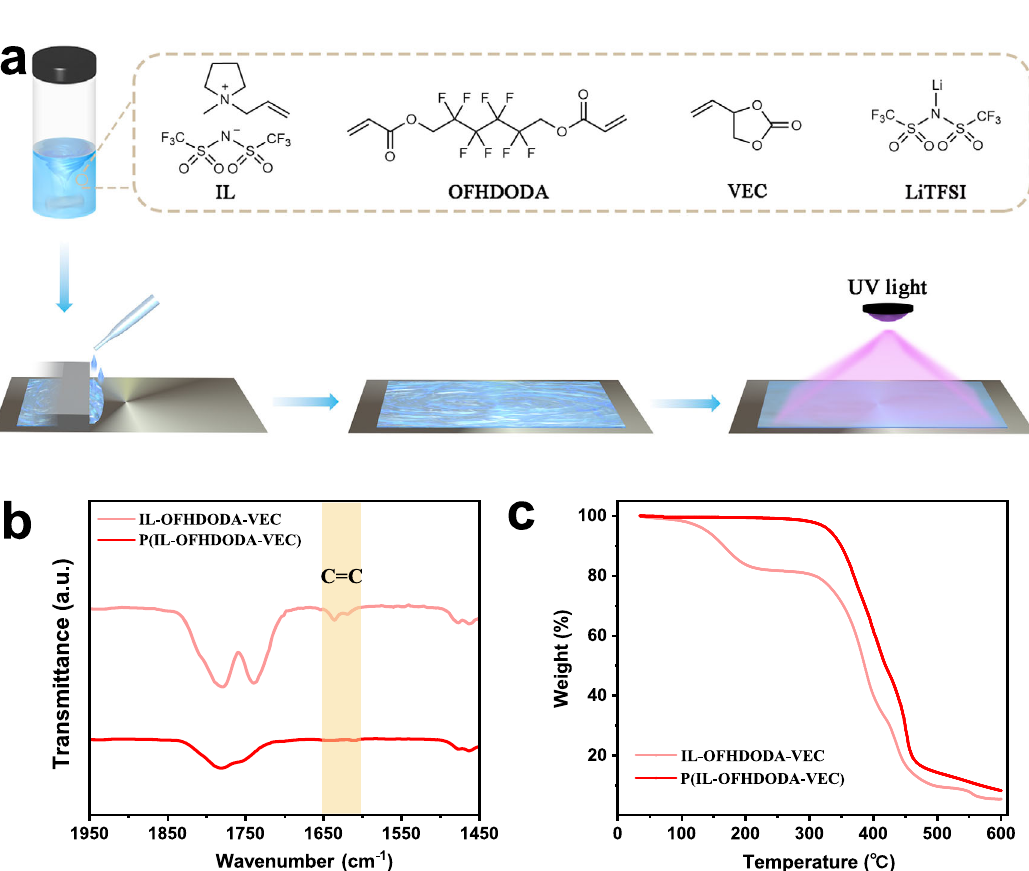
Fig. 1 | Preparation ofSPEs. a Schematic illustration of the preparation of P(IL-OFHDODA-VEC). b , c FTIR spectra( b ) and thermogravimetric curves ( c ) of IL-OFHDODA- VEC and